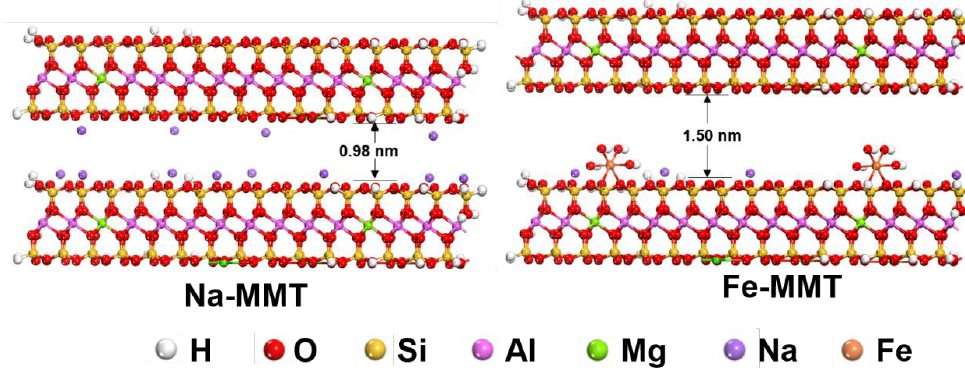
Figure 4. Structure of Na-MMT and a possible structure of Fe-MMT.